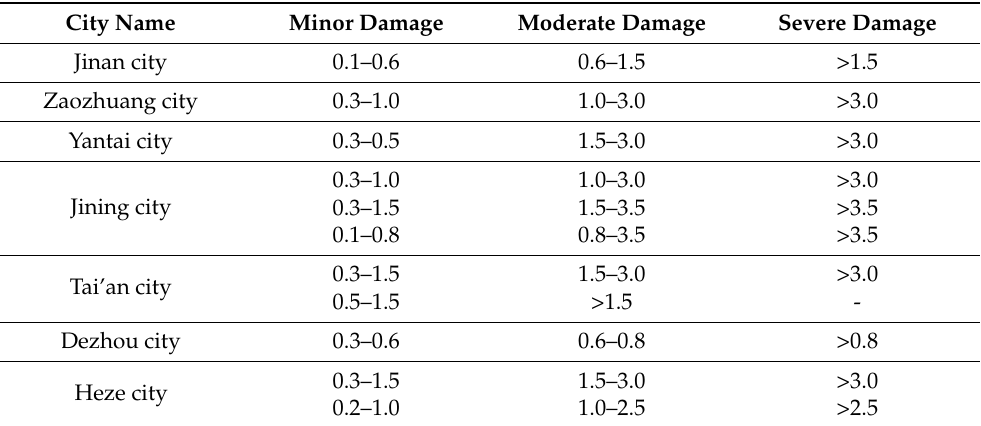
Table 1. Classification standard of farmland damage degree